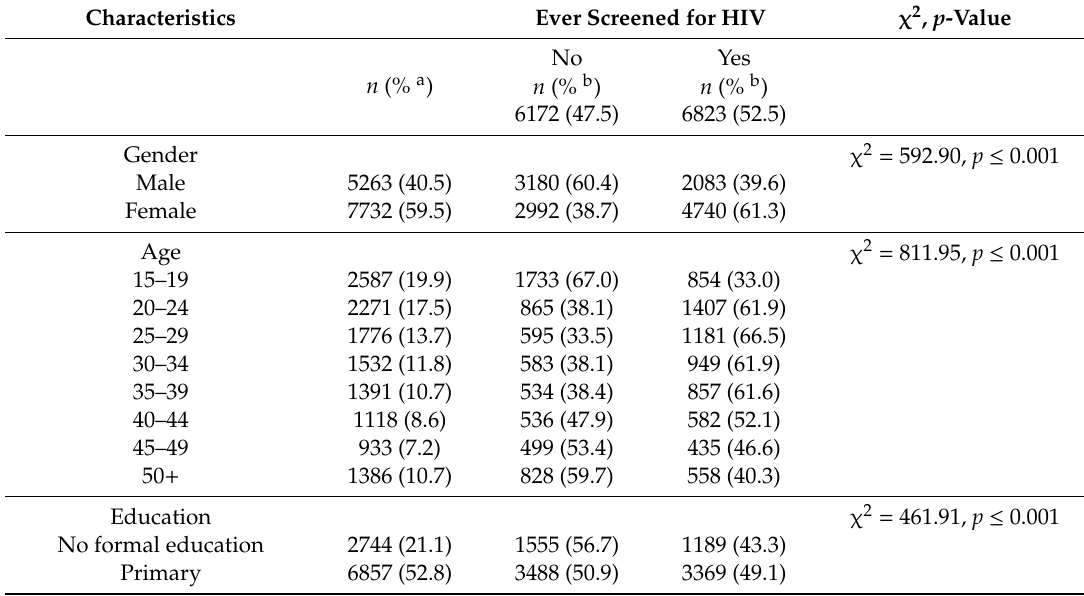
Table 1. Weighted summary statistics and chi-square test of the independence between covariates and the outcome ( n =